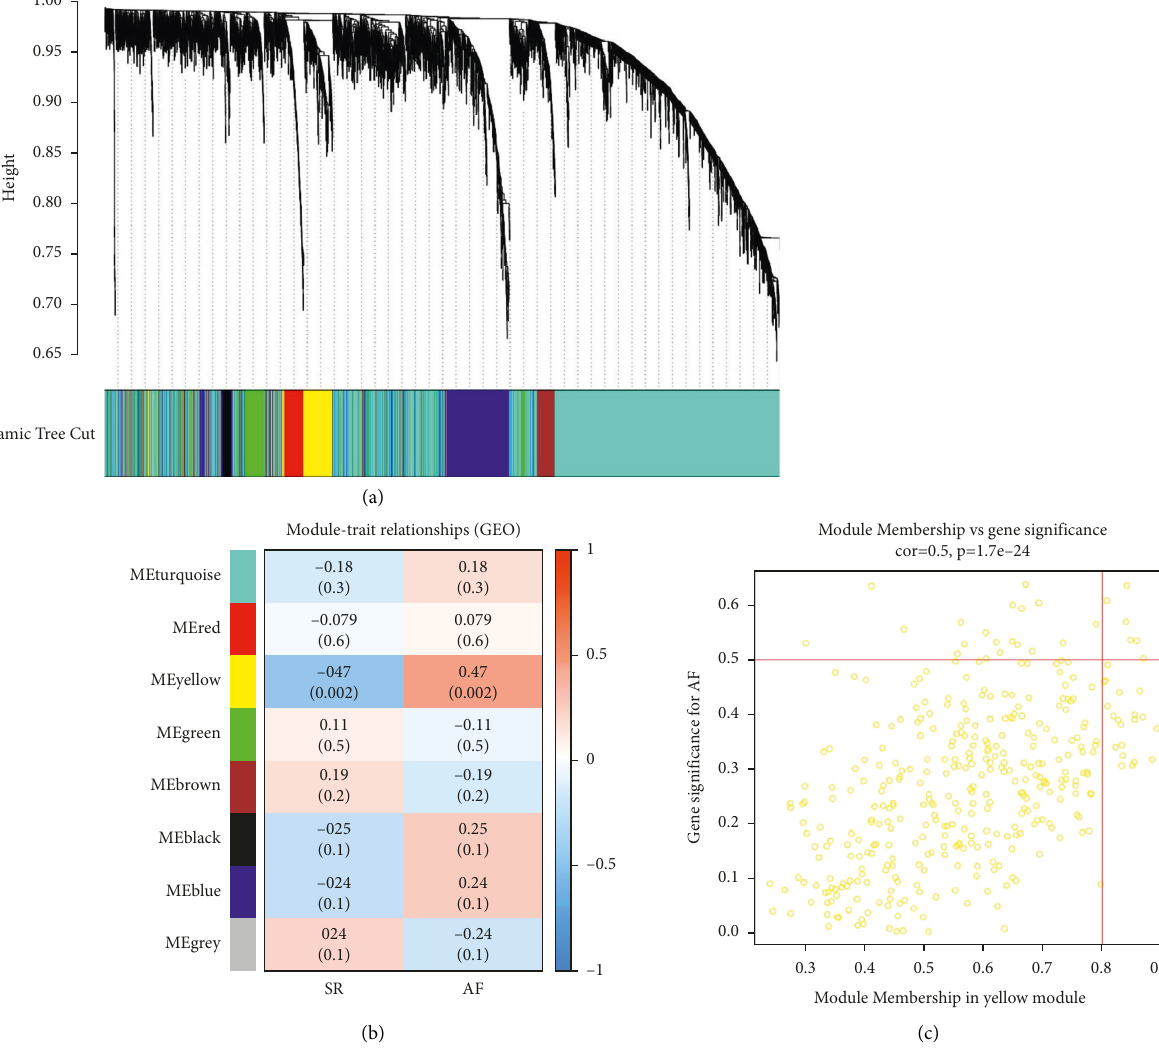
Figure 3: Construction of the weighted co-expression network and module analysis. (a) Differentially expressed genes represented by different colors under the gene tree. (b) Module-trait relationships. The yellow module correlated significantly with atrial fibrillation. (c) The scatter plots show the correlations between the yellow modular gene and atrial